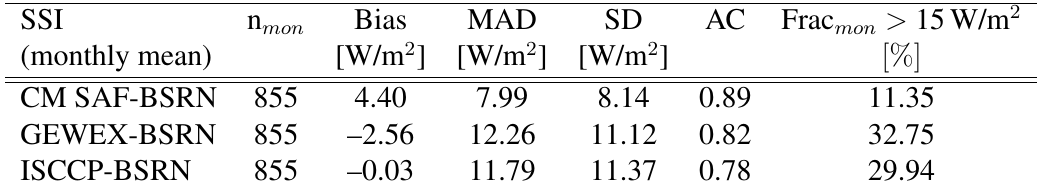
Table 1. Statistics for the comparison of monthly mean SSI between the mean of all BSRN stations and CM SAF as well as GEWEX and ISCCP. MAD is the mean difference gained as average over the absolute bias values, SD is the standard deviation, AC is the anomaly correlation and the last column gives the number of monthly mean with a bias higher than 15 W/m 2 , a threshold resulting from the CM-SAF target accuracy of 10 W/m 2 plus the uncertainty of the ground